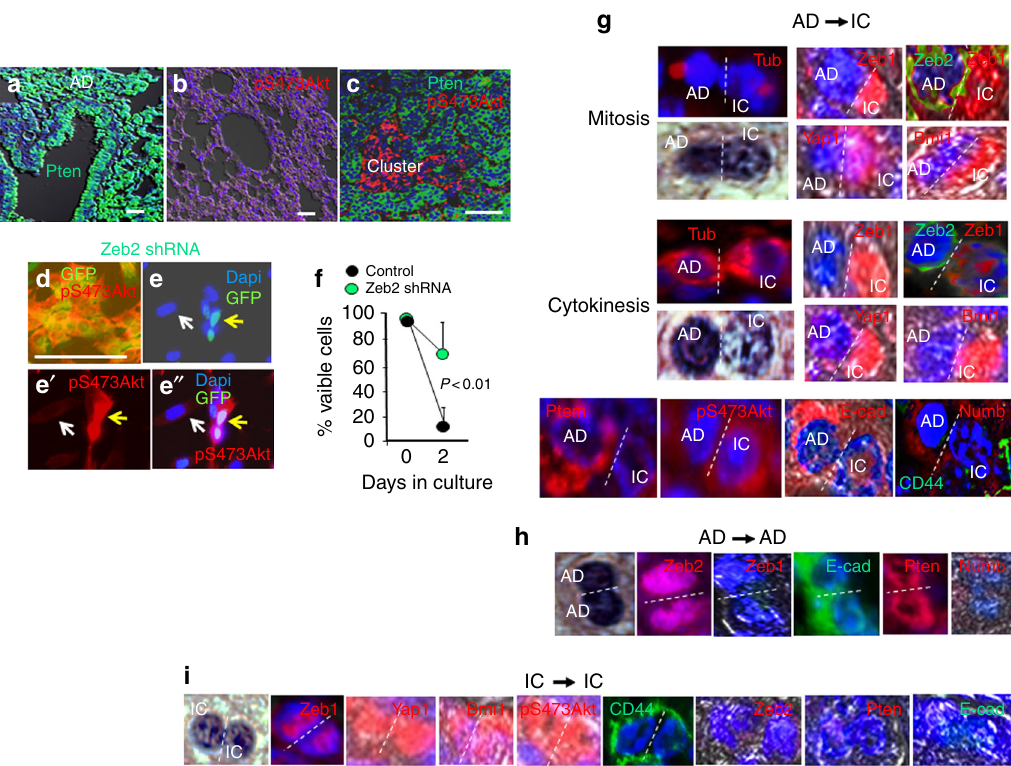
Fig. 5 Pten loss and pS473Akt induction mark clusters, Zeb2 knockdown causes pS473Akt and resistance to anoikis, and asymmetric division of adenoma cells generates IC. a Immunostaining showing Pten in normal lung, AAH, and AD. b Immunostaining showing pS473Akt is low in normal lung, AAH, and AD. c Repression of Pten and induction of pS473Atk marks clusters. d – e ″ In cell culture, shRNA knockdown of Zeb2 causes constitutive pS473Akt. d shows a higher cell density region. GFP is expressed from the lentivirus. The control virus had no effect of pS473Akt. f Consistent with the anti-apoptotic properties of pS473Akt, Zeb2 knockdown cells, displaying constitutive pS473Akt, showed increased survival (resistance to anoikis) when placed in suspension culture for 48 h. Bars are 50 μ m. g Dividing cells in clusters were identi fi ed by immunostaining for Tubulin (Tub) + mitotic spindles. Cells displaying patterns of mitosis or cytokinesis, as well as the morphology of dividing cells, were examined. We noted mitotic cells where one pole displayed dense heterochromatin of AD cells, whereas the opposite pole showed decondensed chromatin of IC. Immunostaining showed that Zeb1, Yap1, and Bmi1 co-localized with decondensed chromatin, whereas Zeb2 was restricted to dense chromatin. This transcription factor polarization persisted in cytokinesis. The pole of the dividing cells with Zeb2 + compact chromatin showed an E-cadherin + , CD44 − , Pten + , pS473Akt − pattern of parent adenoma cells during cytokinesis, whereas the opposite pole with Zeb1 + , Bmi1 + , Yap1 + decondensed chromatin had transitioned to an E-cadherin − , CD44 + , pS473Akt + pattern of daughter IC. Notably, Numb, which was not evident in adenoma cells, was induced in the dividing cells and it co-localized asymmetrically with E-cadherin during cytokinesis. h Outside of EF5 + regions in AD, AD cells divide symmetrically to produce AD daughters. i We identi fi ed other dividing cell in clusters that did not display nuclear polarization, and showed uniform chromatin decondensation in both poles. These dividing cells maintained the E-cadherin − , Zeb1 + , CD44 + , Zeb2 − , Pten − , pS473Atk + , Bmi1 + , nuclear Yap1 pattern of IC in both poles. Although Numb was maintained in these dividing IC, it was symmetrically distributed. Cells type and number of dividing cells in clusters is quanti fi ed in Fig.